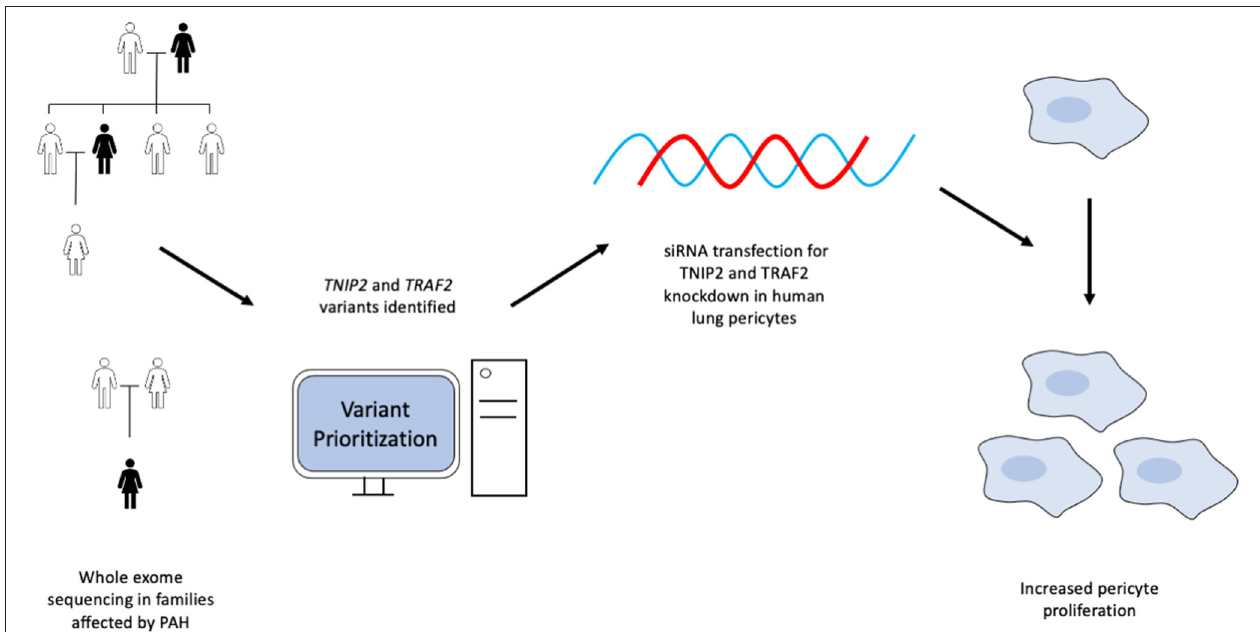
FIGURE 4 | Graphical abstract summarizing the experimental design and results from the